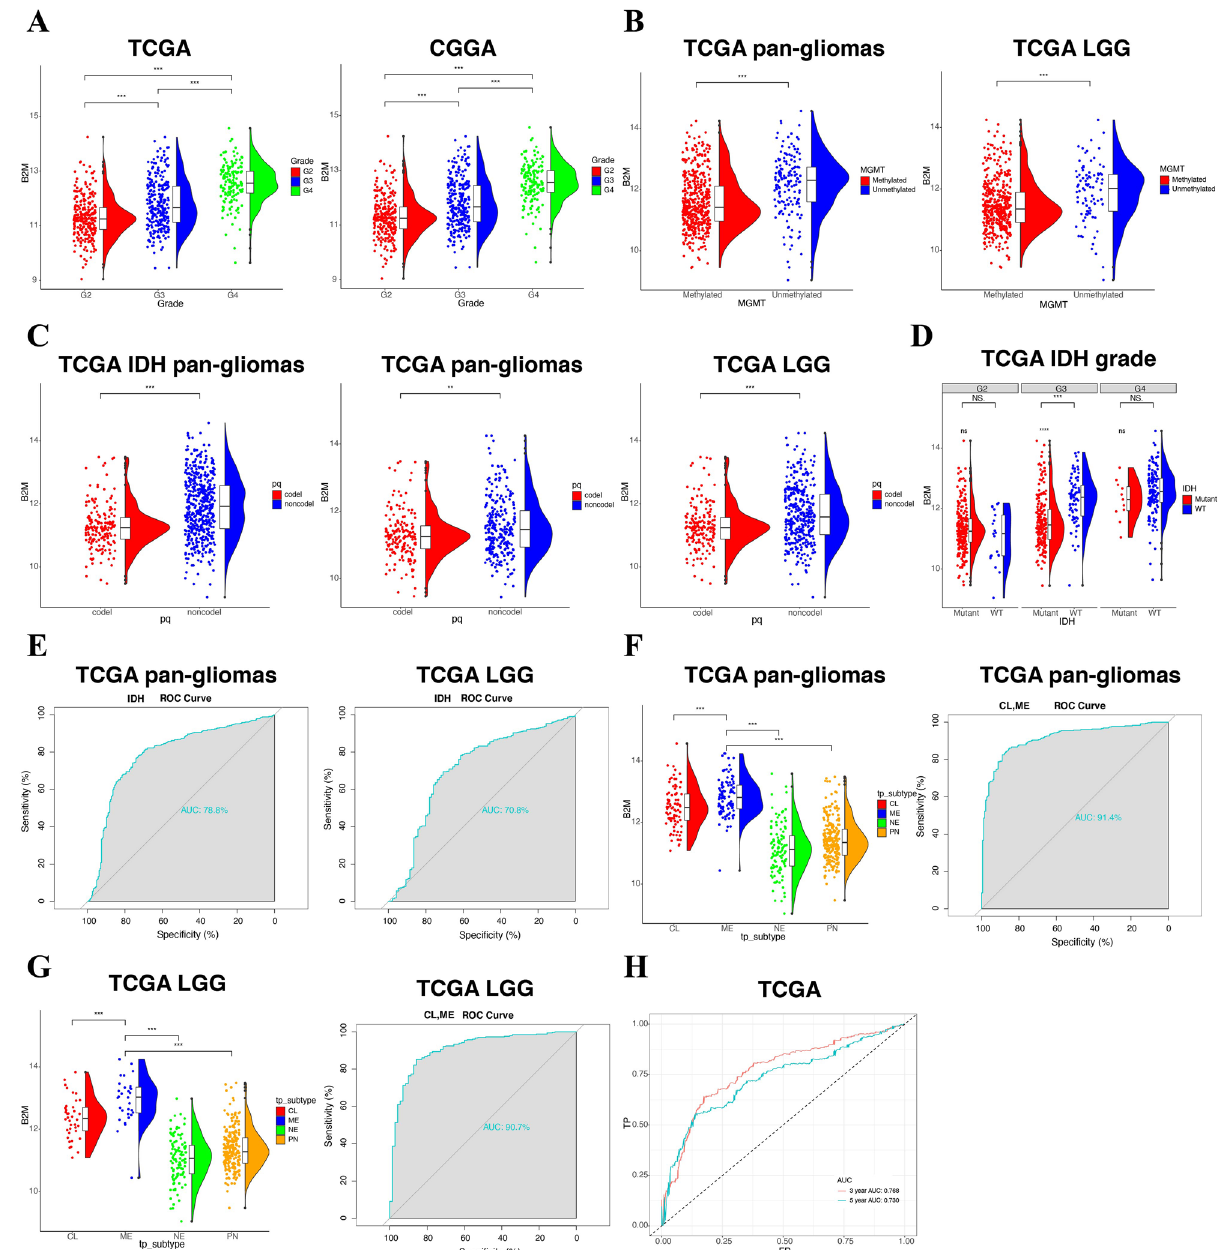
Figure 1. The correlation between B2M expression and diverse characteristics. ( A ) B2M expression in different WHO grades from TCGA and CGGA. ( B ) Association between B2M and MGMT methylation in pan-gliomas and LGG from TCGA. ( C ) Association between B2M and 1p/19q state in pan-gliomas with IDH mutant, pan- gliomas, and LGG samples from TCGA. ( D ) B2M expression in different IDH state from TCGA dataset. ( E ) Receiver operating characteristic (ROC) curve analysis showed that B2M had 78.8% and 70.8% sensitivity and specificity to predict IDH wild-type state gliomas and LGGs, respectively. ( F ) The B2M expression pattern in pan-gliomas from the TCGA molecular subtype. ROC curve analysis showed that B2M had 91.4% sensitivity and specificity to predict CL and ME subtype gliomas. ( G ) The B2M expression pattern in LGGs from the TCGA molecular subtype. ROC curve analysis showed that B2M had 90.7% sensitivity and specificity to predict CL and ME subtype gliomas. ( H ) ROC curve to assess sensitivity and specificity of B2M expression as a diagnostic biomarker in 3 years and 5 years, respectively. *P < 0.05, **P < 0.01, ***P < 0.001. G2 Grade II, G3 Grade III, G4 Grade